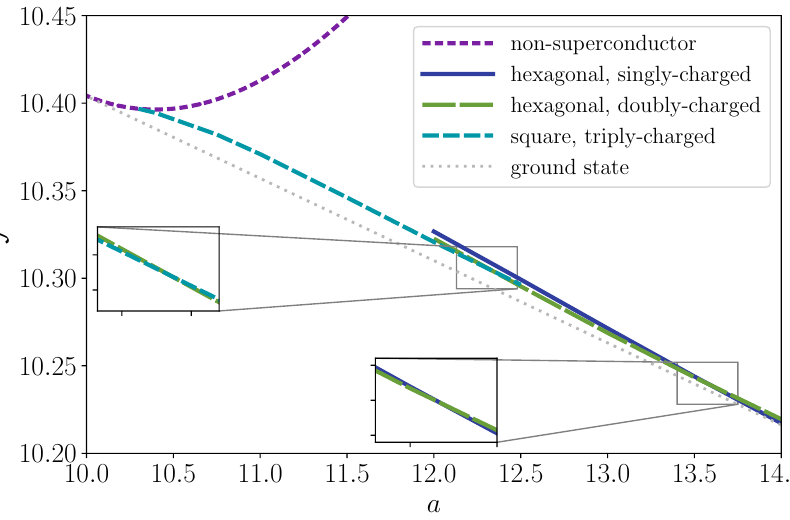
( a ) , for various lattice F